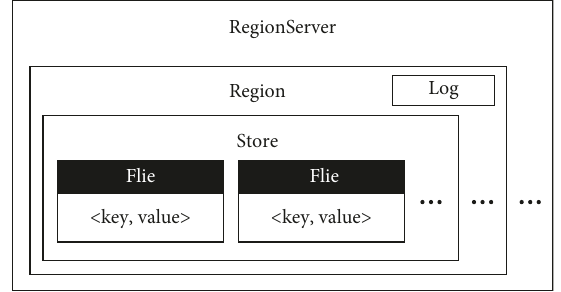
Figure 1: The composition of HBase.